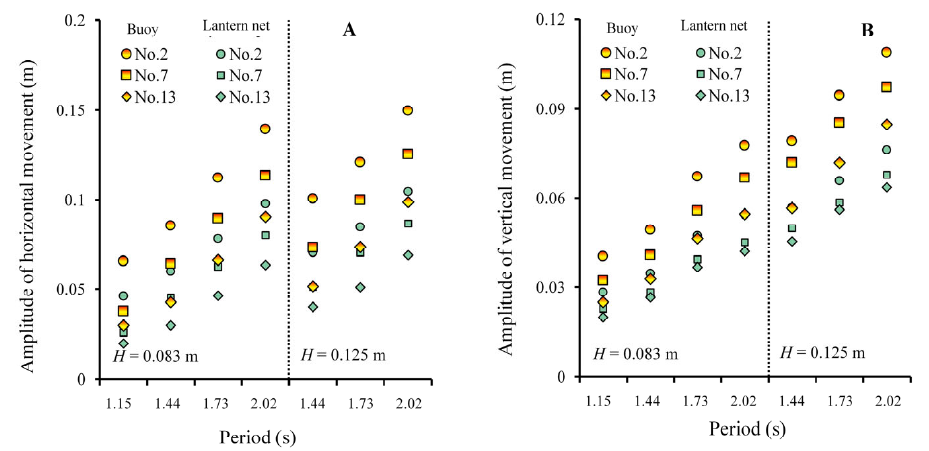
Figure 7. Amplitudes of ( A ) horizontal movement and ( B ) vertical movement of the Nos. 2, 7, and 13 pairs of buoy and lantern nets in the wave conditions at wave periods of 1.15–2.02 s and wavelengths of 8.3 and 12.5 cm.